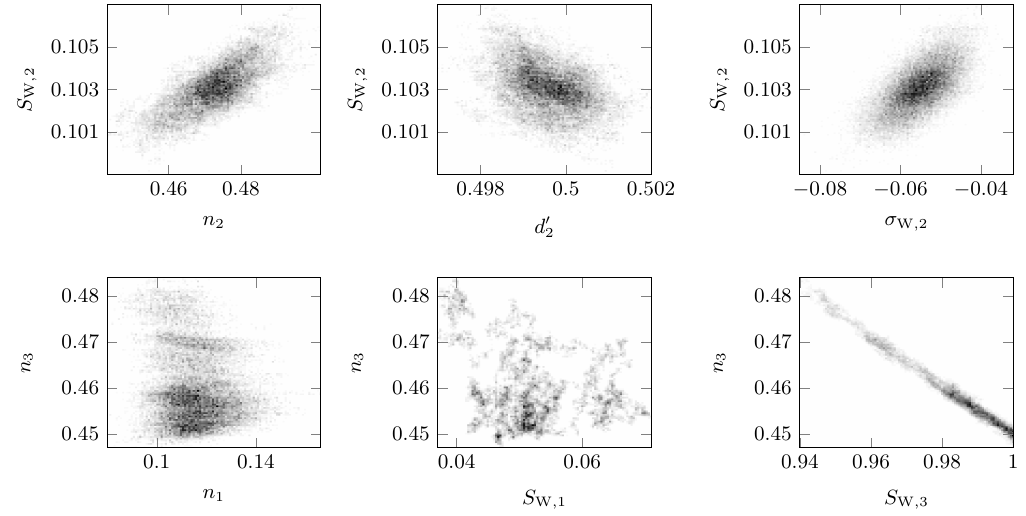
Figure 7. Selected correlation plots for setup (iii). Only some significant and typical plots, like strong correlation ( n 3 vs. S W,3 ), no correlation ( S W,2 vs. d (cid:48) ), weak correlation ( S W,2 vs. σ W,2 ) etc., are shown. 2 The other correlation plots were similar to the displayed